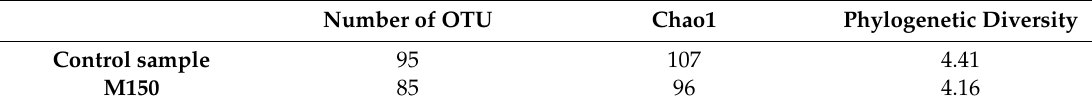
Table 1. Values of the metapopulation biodiversity coe ffi cients for microorganisms after 168 h of